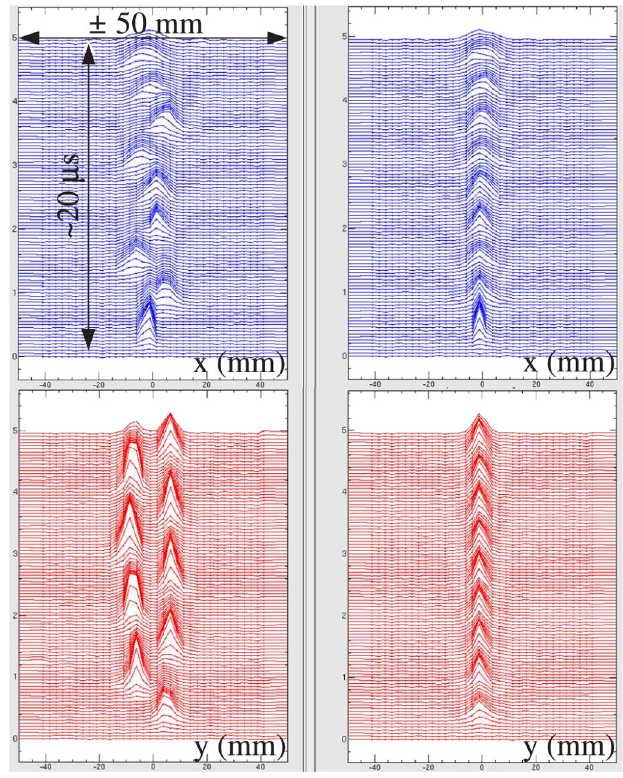
FIG. 10. (Color) Horizontal (upper) and vertical (lower) beam profile mountain views for the first nine turns measured with IPM before (left) and after (right) the injection error correction.